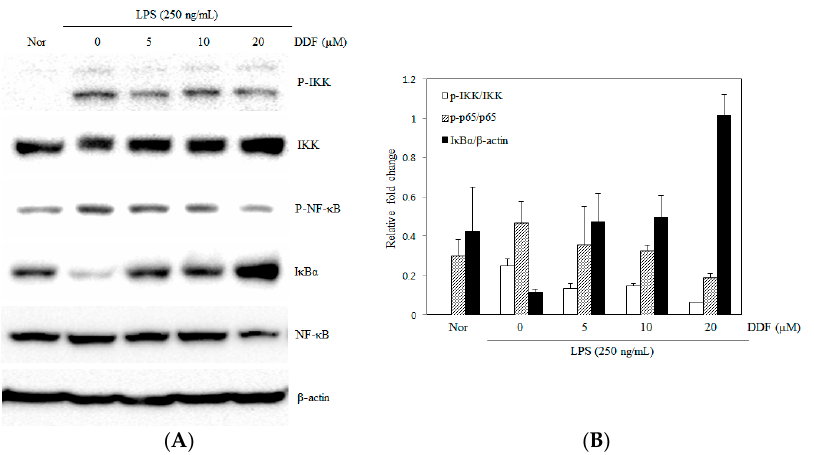
Figure 6. Effect of DDF on I κ B α degradation and phosphorylation of IKK and NF- κ B (p65) in LPS-stimulated RAW 264.7 cells. ( A ) Cells were pretreated with three different concentrations of DDF for 30 min. To evaluate the levels of p-IKK, IKK, I κ B α , p-NF- κ B, and NF- κ B, the cells were stimulated with LPS for 30 min, after which the cell lysates were analyzed by immnoblot analysis; ( B ) Immunoblot signals were quantified using Molecular Analyst/PC densitometry software (Version 4.6, Bio-Rad).